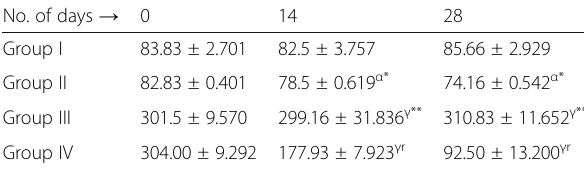
Table 1 The effect of Momordica charantia on FBG level